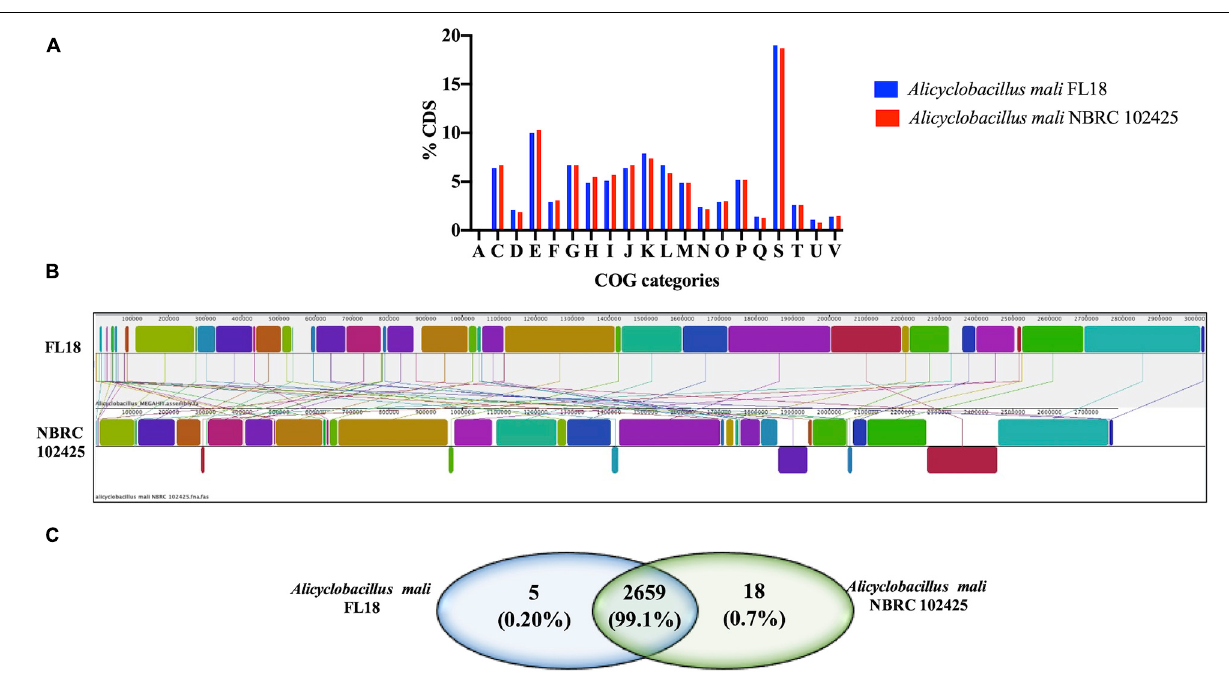
Frontiers in Microbiology |